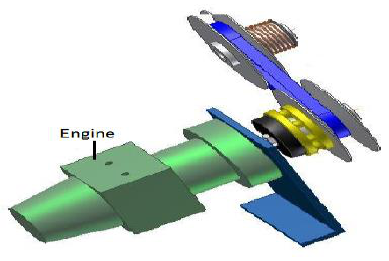
Figure 2 - closed loop control system